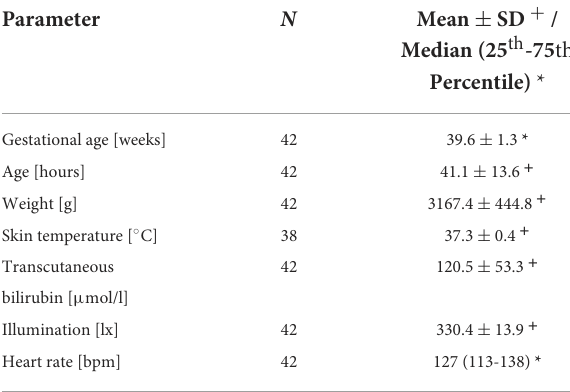
TABLE 1 Demographic and clinical characteristics of the study population.